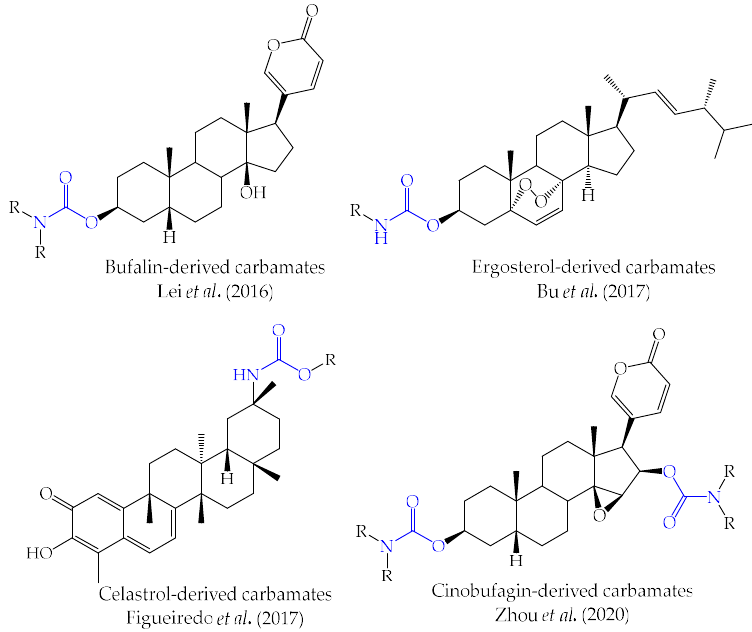
Figure 2. Recently reported in vitro and in vivo active steroidal carbamates [24,25,26,27].